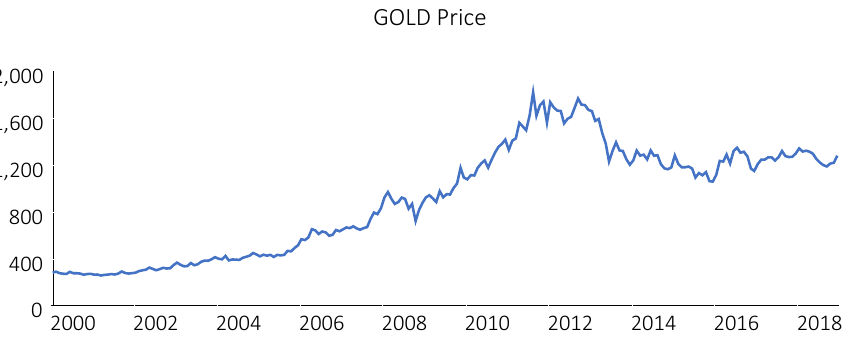
Figure 3. International gold price per ounce in US dollars during 2000–2018